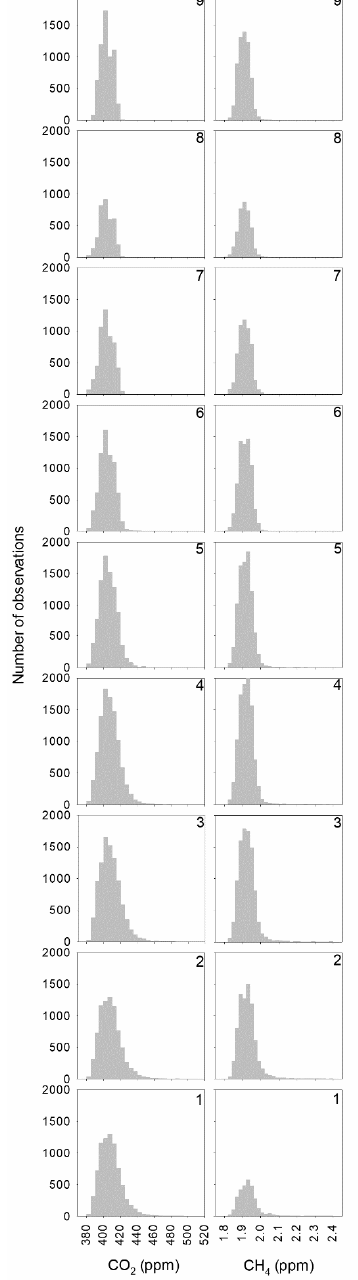
Figure 3. Concentration histograms following the wind speed classification.